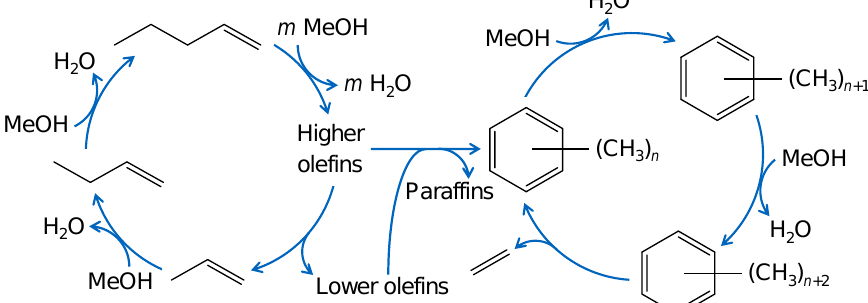
Figure 5. Simplified reaction network for MTO over ZSM-5 with the olefin based cycle on the left and the aromatics based cycle on the right side; the latter produces mainly ethene, whereas aromatics and paraffins are formed both through olefin interconversion reactions and a methanol induced pathway, adapted from